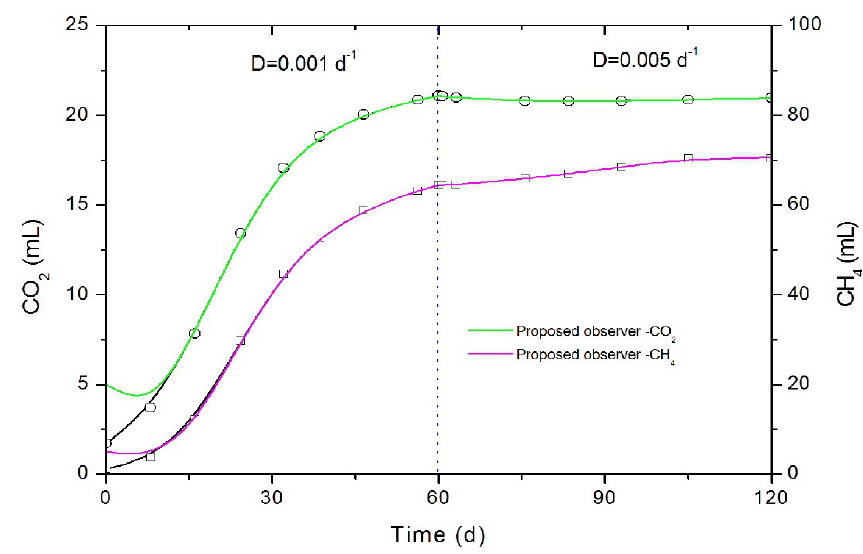
Figure 8. The CO 2 and methane dynamics in the presence of abrupt disturbance to 60 days on process.